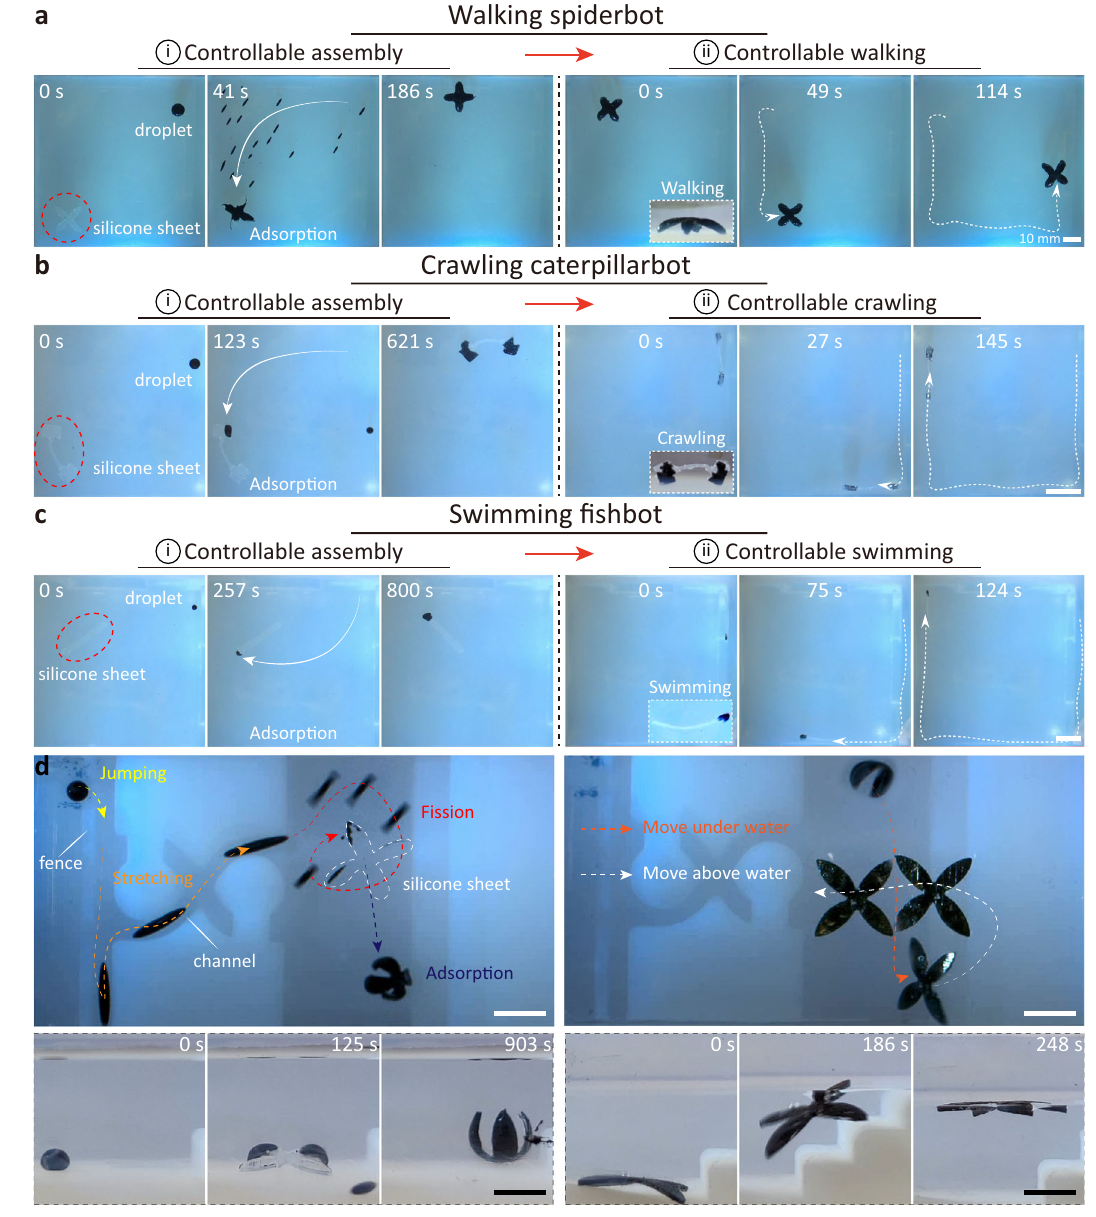
Fig. 7 | Mobile liquid skin converts inanimate objects to miniature soft machines.a Theliquidskinturnssiliconesheetintowalkingspiderbot. b Theliquid skinturnssiliconesheetintocrawlingcaterpillarbot. c Theliquidskinturnssilicone sheetintoswimming fi shbot. d Theupperleft:theactiveliquidskintravelsthrough a complex maze to reach the silicone sheet, which is transformed into a mobile